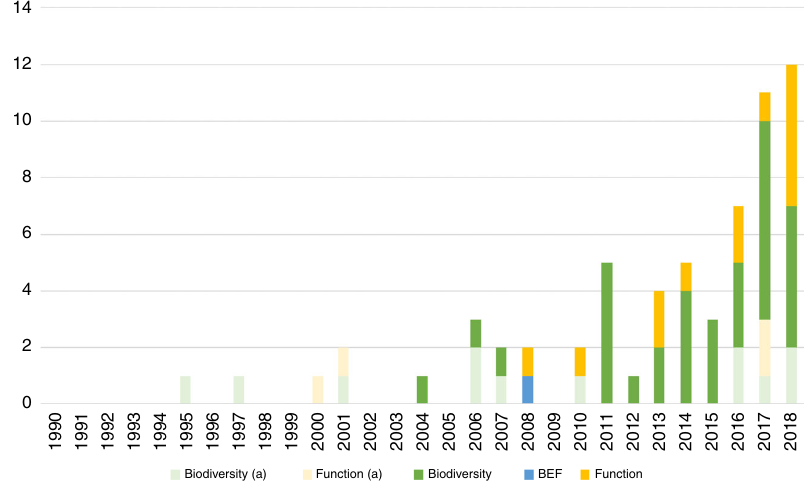
Fig. 4 Accumulated number of papers screened for this analysis. Studies were classi fi ed in soil biodiversity, function or biodiversity, and ecosystem function (BEF), according to the subject of the study (see Table 2). a corresponds to the number of studies that were not included due to the underlying data not being suited for this analysis (e.g., based on national level information) or data availability issues. Overall, ~72.6% of the total number of studies identi fi ed as suitable were included in the analysis ranging from 2004 to 2018.